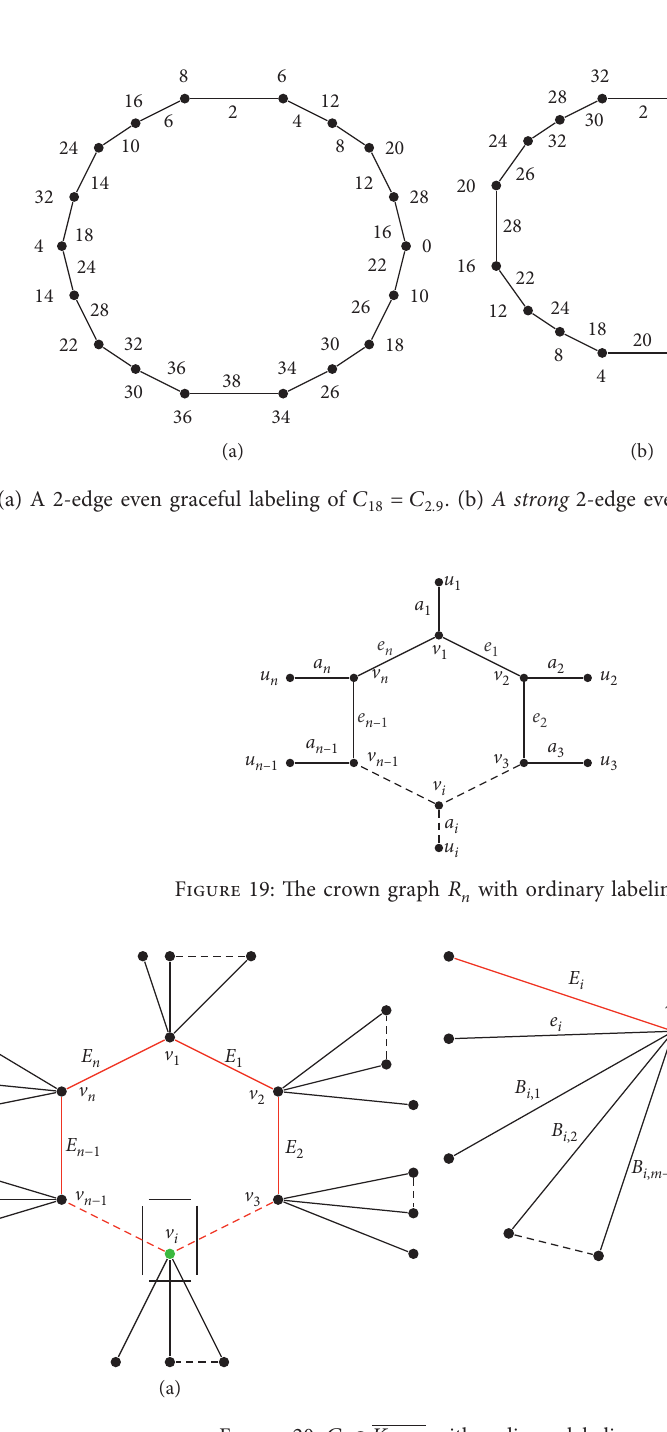
K with ordinary n ⊙ 2 m − 1